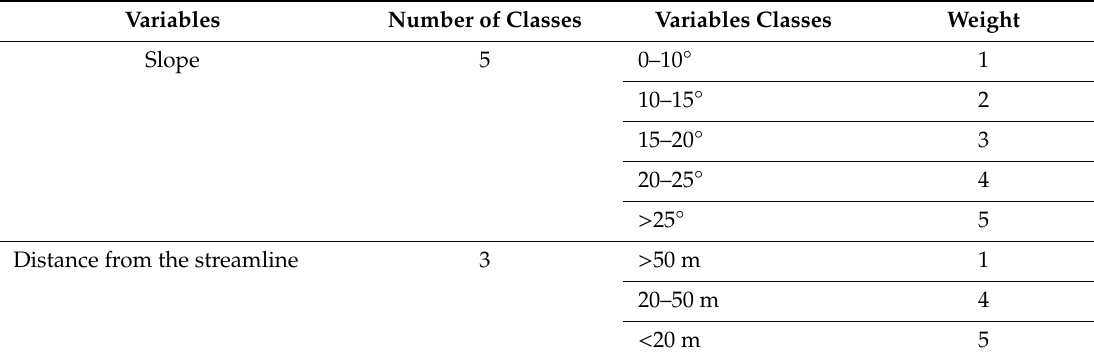
Figure 4. Variables selected to integrate the model of mass movements susceptibility in Funchal: ( a ) slope; ( b ) distance from the streamline; ( c ) drainage density; ( d ) Runo ff Curve Number (CN), and zonation of intense precipitation levels indicated in Figure 2d. Table 3. Variables and weights considered in the susceptibility